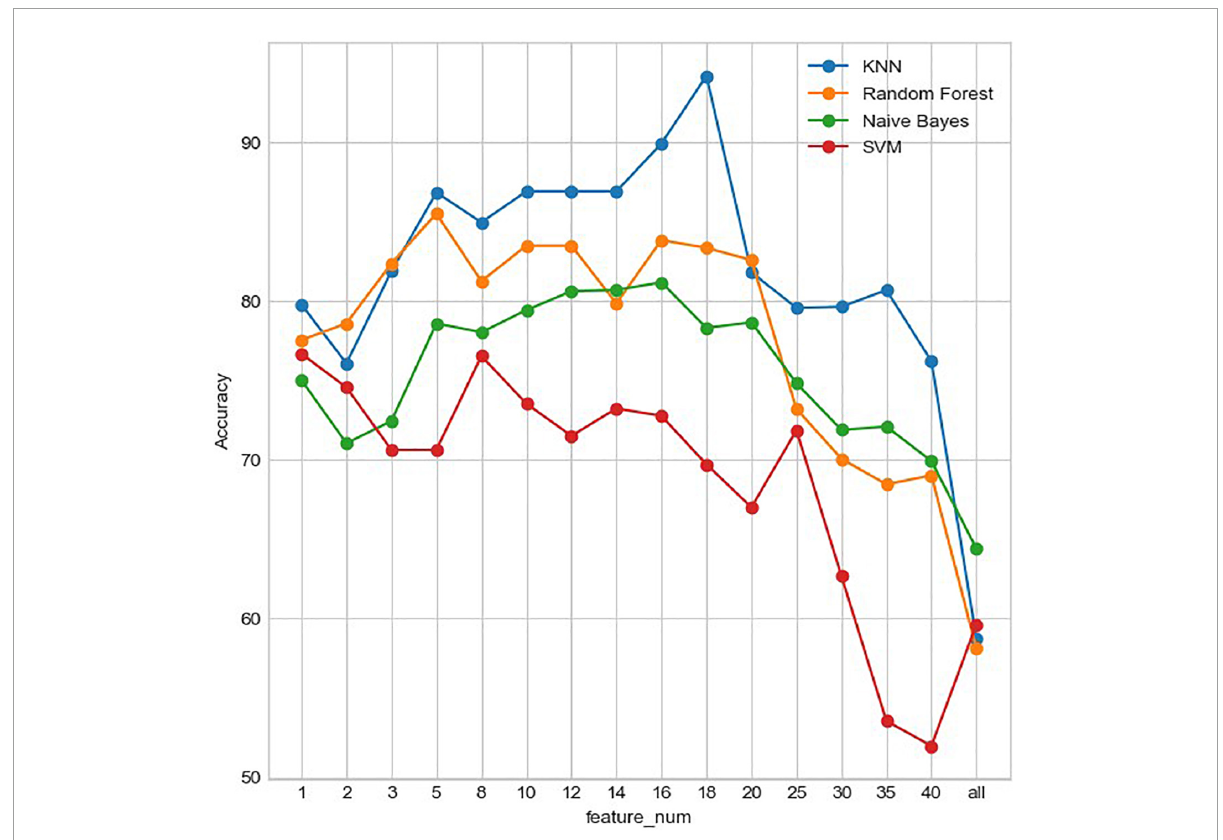
FIGURE7 Accuracy of different classification models with the different number of features.